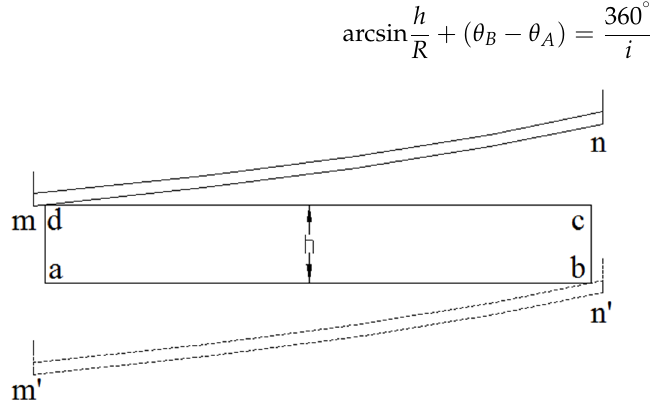
Figure 4. Schematic diagram of continuity analysis.